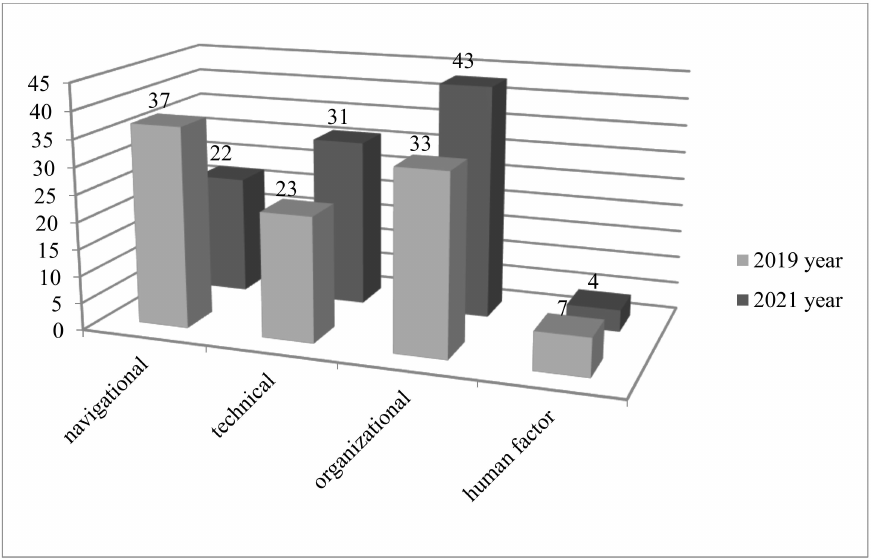
Figure 2. Groups of factors that lead to emergencies on water transport by comparing the data of 2019 and 2021, according to their share in the total number of accidents,